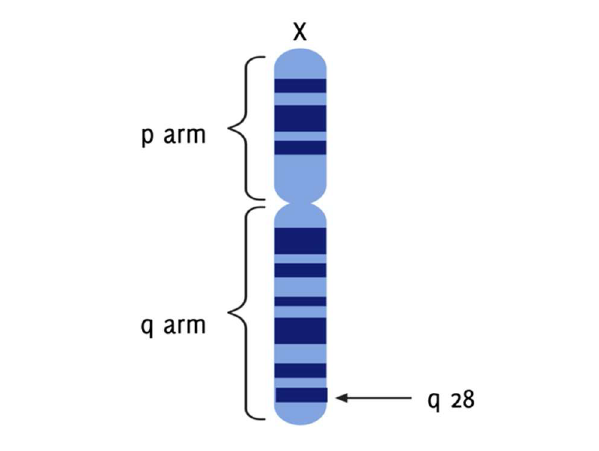
Figure 4 . g6pdx Gene Located on the Telomeric End of the q Arm at Band 28 of the X Chromosome